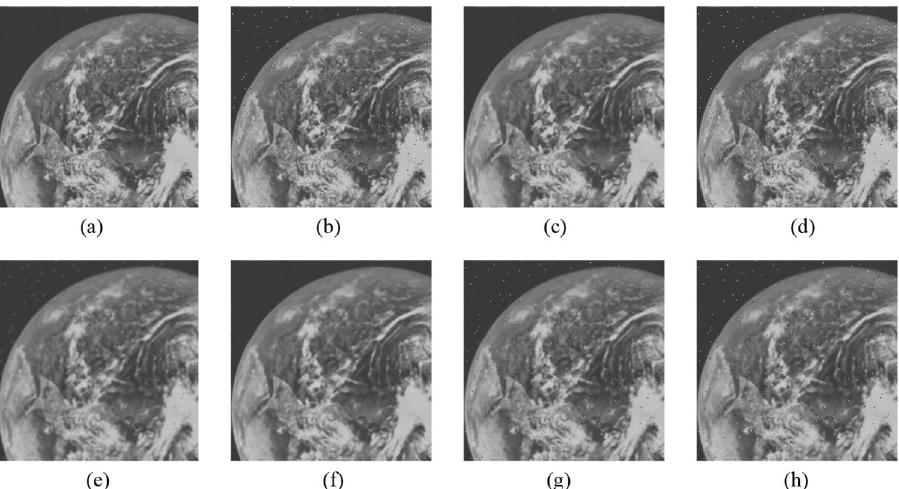
Figure 10. Comparison of denoising performance of each filter against the salt-and-pepper noise (“Earth”). ( a ) Original image; ( b ) noise-added image; ( c ) filtered image using abwFMGFI; ( d ) filtered image using NLMF (templateWindowSize: 21, searchWindowSize: 7); ( e ) filtered image using GF (σ_x: 5, σ_y: 5); ( f ) Filtered image using MF; ( g ) filtered image using BF (σ_c: 35, σ_s: 5); ( h ) filtered image using ABF (σ_s: 7, max_σ_c: 35).